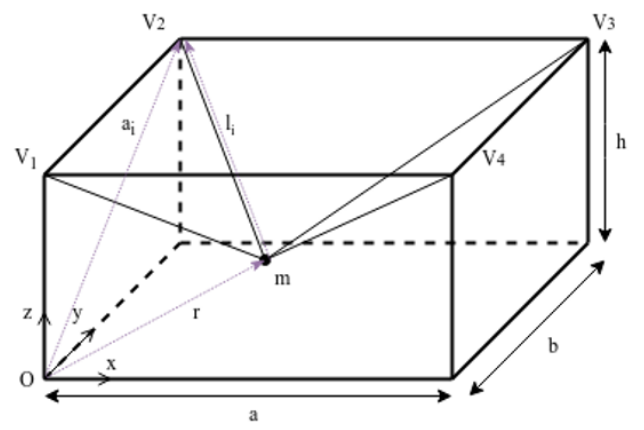
Figure 1. Structure of the considered suspended cable